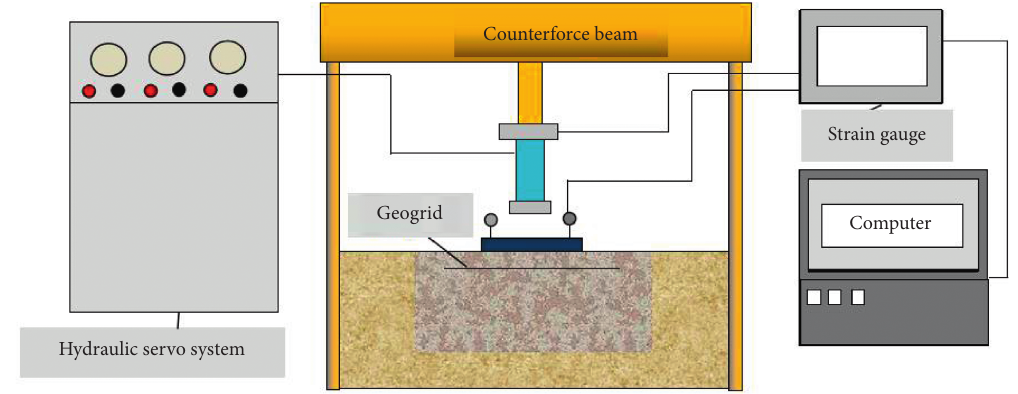
Figure 1: Schematic diagram of loading device for the model